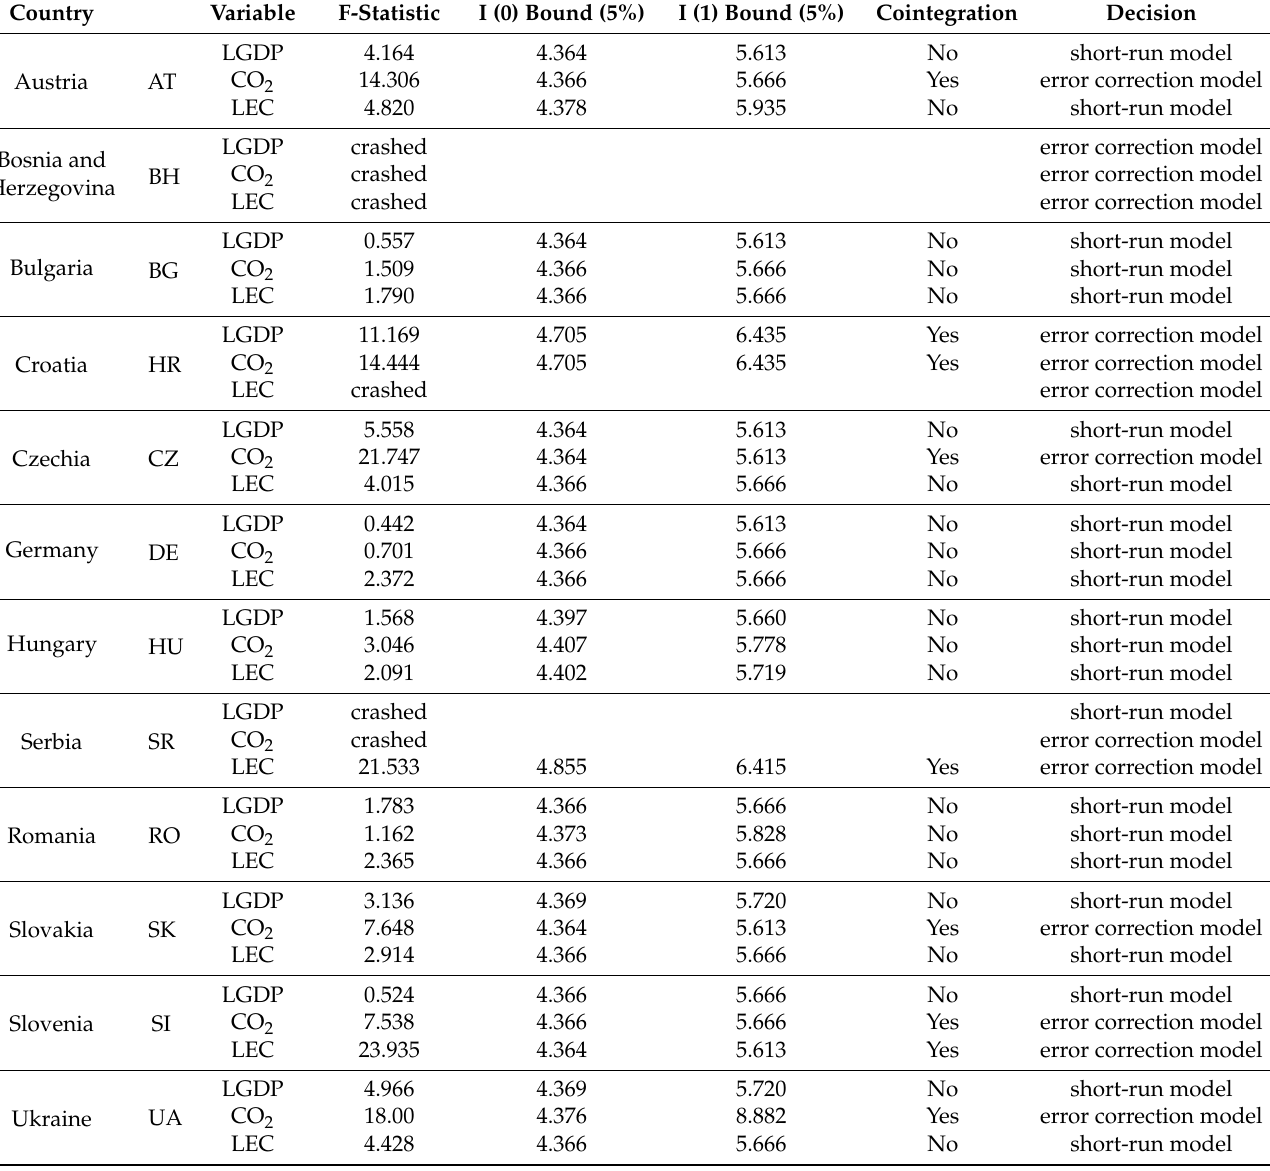
Table 3. The ARDL bound testing for cointegration with Kripfganz and Schneider [57] critical values and approximate p